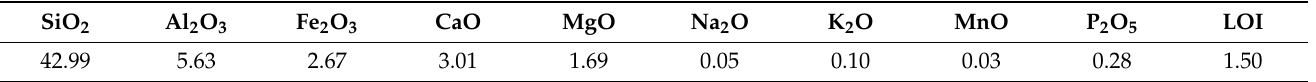
Figure 1. Soil sample location map of Aceh Province — Indonesia. Table 1. Chemical composition (%) of the dry untreated clay.